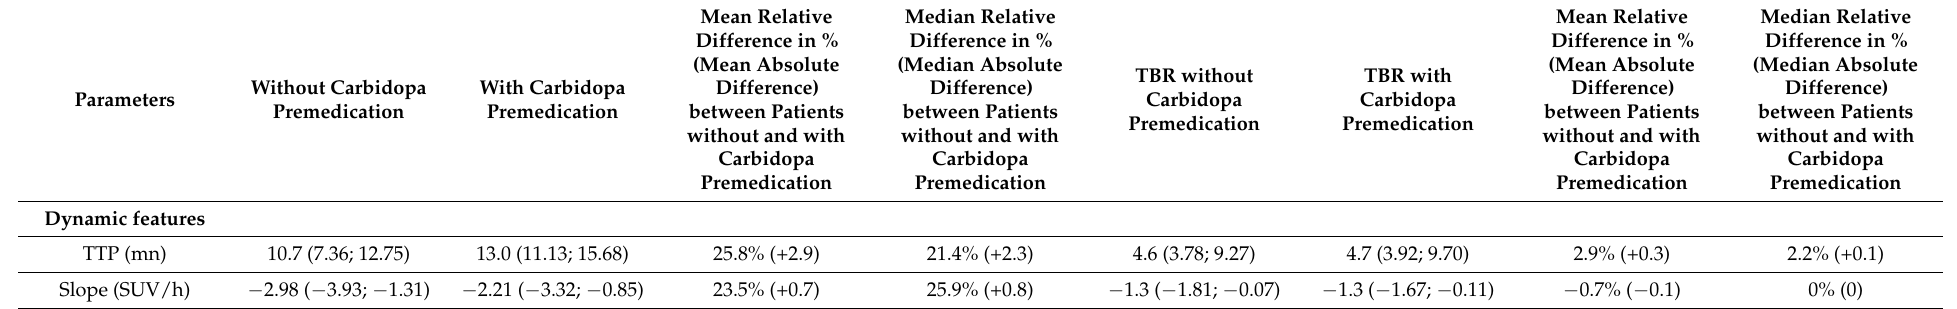
Table 4. Brain tumor extracted dynamic parameters in simulations and after normalization for healthy brain parameters with Tumor-to-normal-Brain Ratios (TBRs).